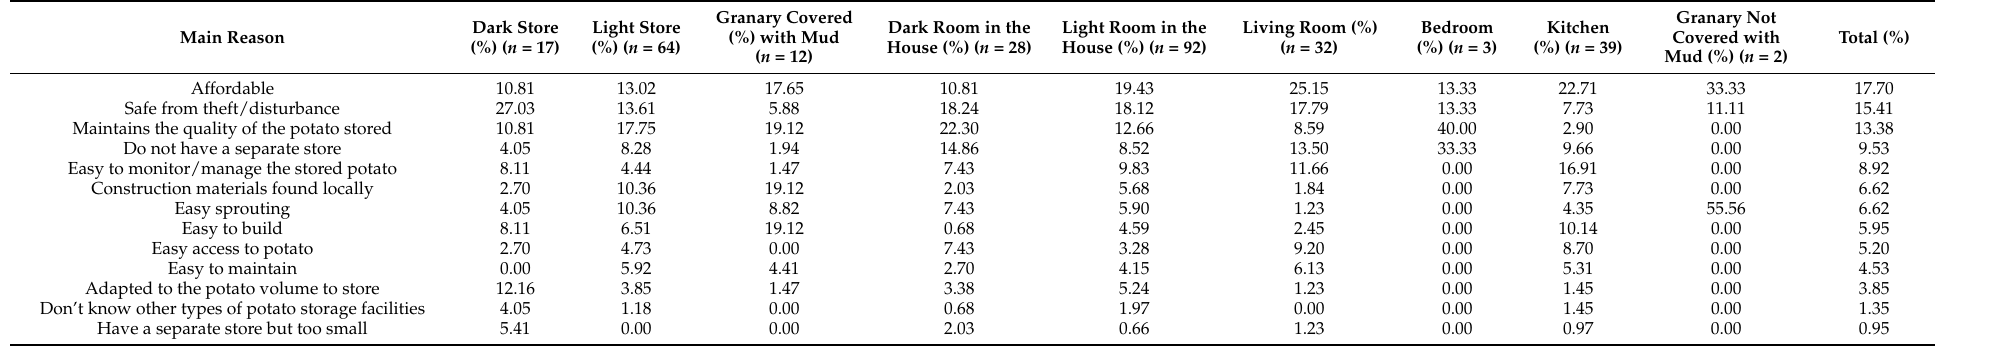
Table 7. Main reasons storage facilities used by potato